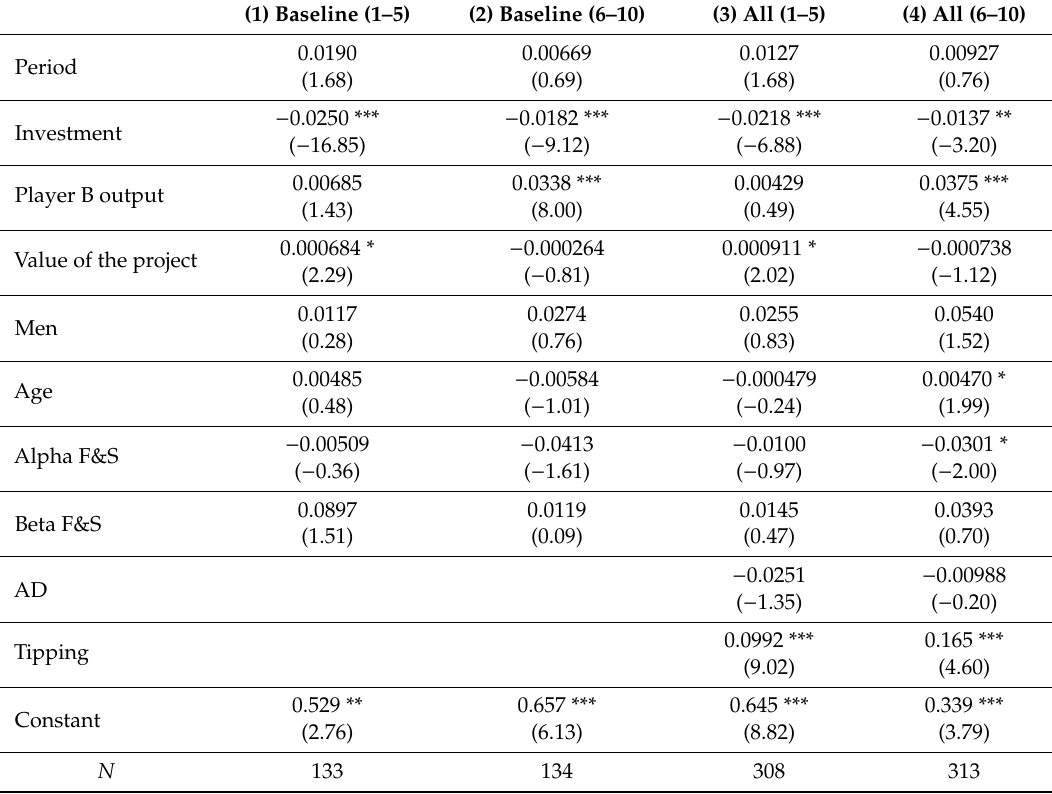
Table A5. Random GLS models for the first 5 periods and the 5 last